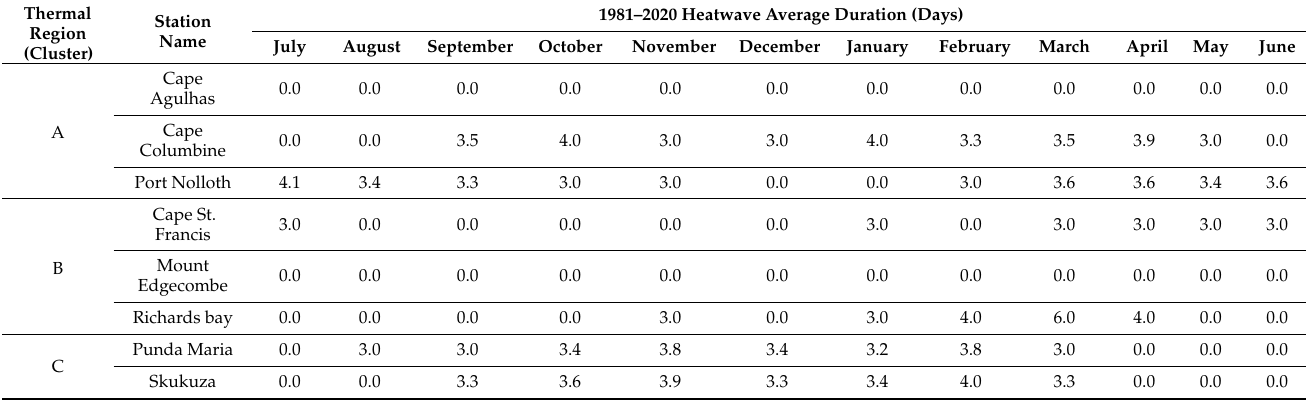
Table 4. The monthly HW average duration from 1981–2020 from the 24 selected